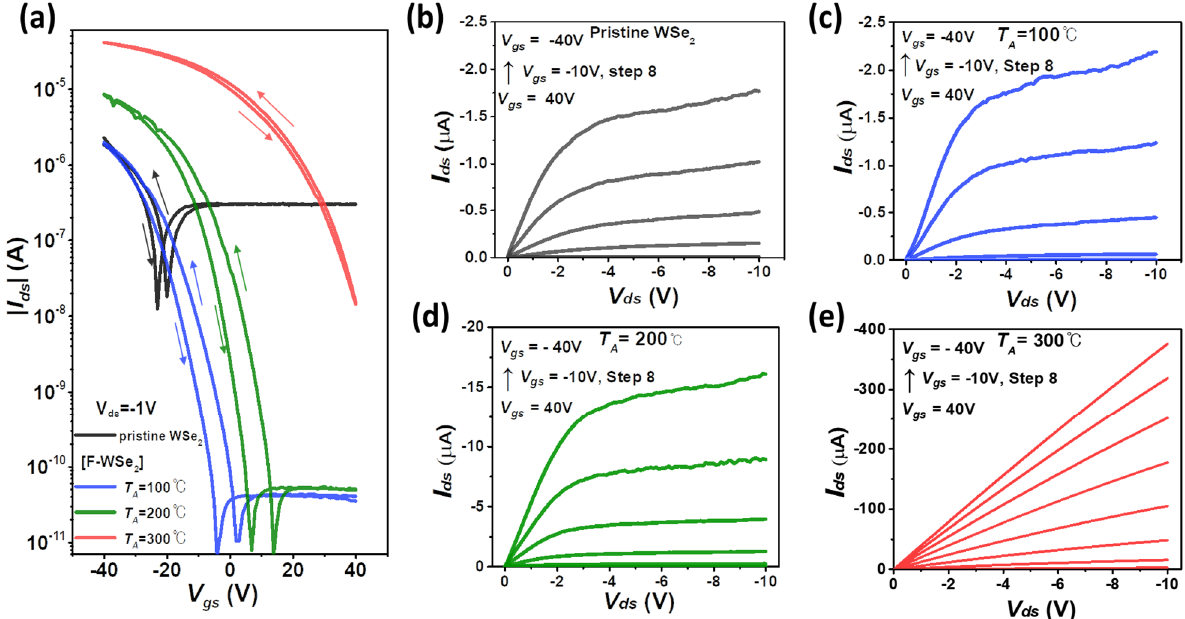
Figure 2. Electrical characteristics of the tungsten diselenide (WSe 2 ) device. ( a ) Change in transmission curve for T A = 100, 200, and 300 °C for the pristine WSe 2 device and F-WSe 2 device; ( b ) output curve of pristine WSe 2 transistor; output curve of F-WSe 2 transistor annealed at T A = ( c ) 100 °C, ( d ) 200 °C, and ( e ) 300 °C.